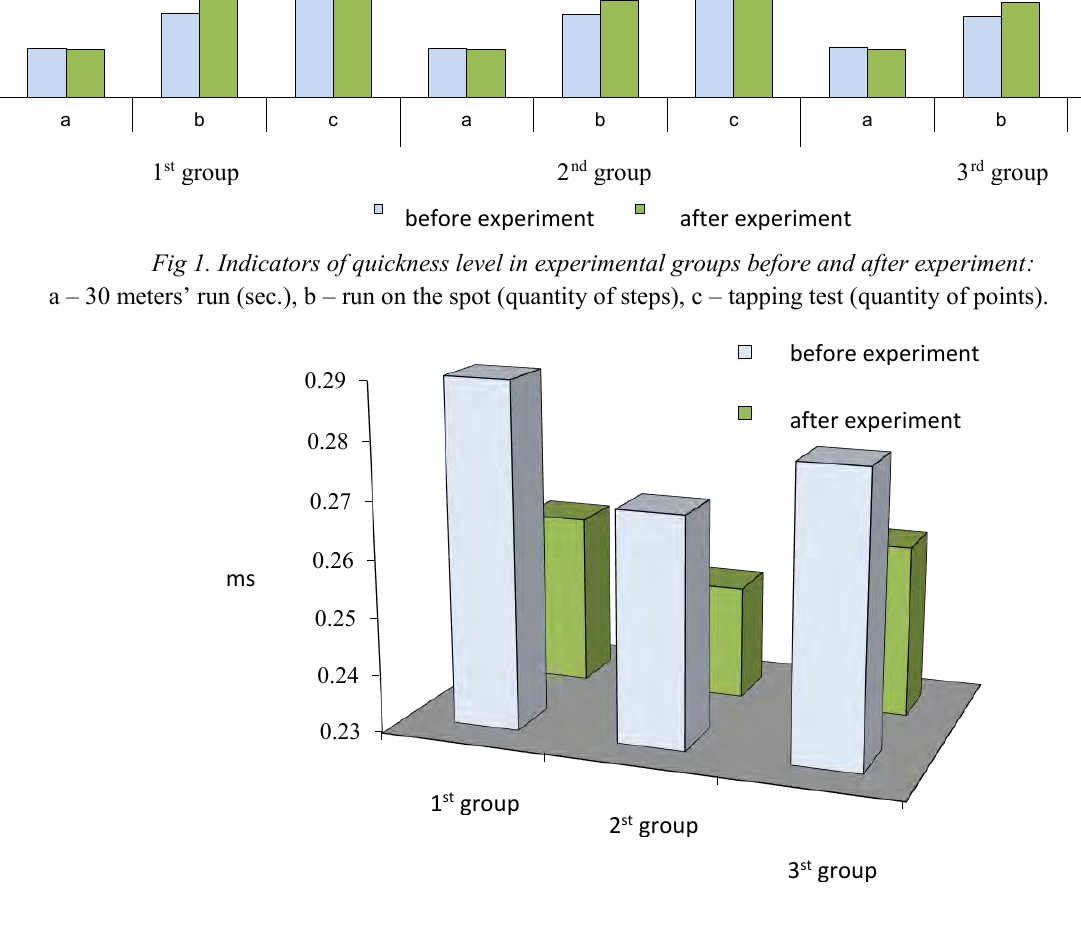
Fig. 2. Indicators of motor response in experimental groups before and after